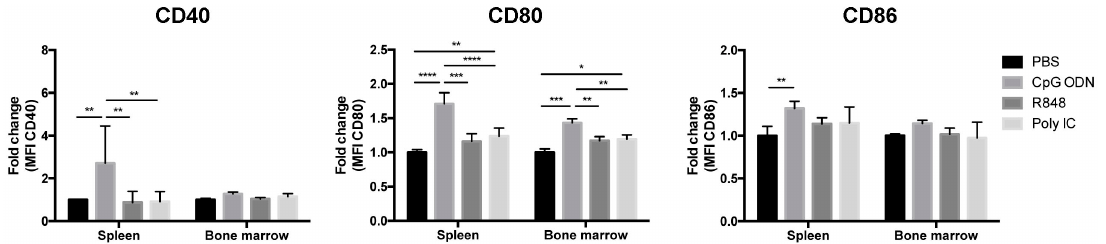
Figure A2. TLR-induced upregulation of co-stimulatory molecules on macrophages of mice bearing B-ALL. Graphs depict the fold change in the expression levels of CD40 (left panel), CD80 (middle panel) and CD86 (right panel) on macrophages in bone marrow and spleen were measured three days after a single-dose treatment with endosomal TLR agonist. The geometric MFI is shown. Tukey’s multiple comparisons test, bars represent mean ± S.D.; * p < 0.05, ** p < 0.01, *** p < 0.001, **** p < 0.0001. Results shown are pooled from four independent experiments; PBS-treated mice (n = 15); CpG ODN-treated mice (n = 14); R848-treated mice (n = 15); PolyI:C-treated mice (n = 17).